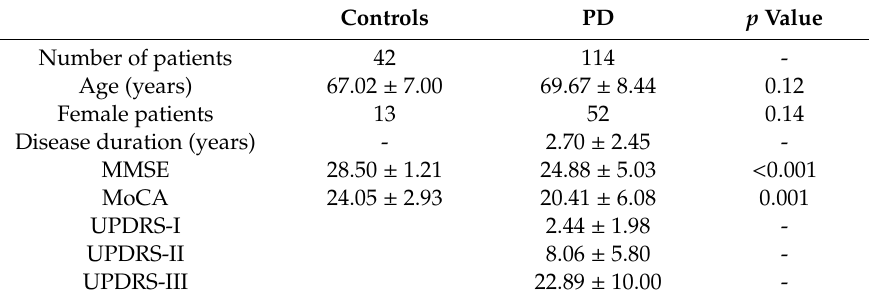
Table 1. Demographic data of patients with Parkinson’s disease (PD) and controls.